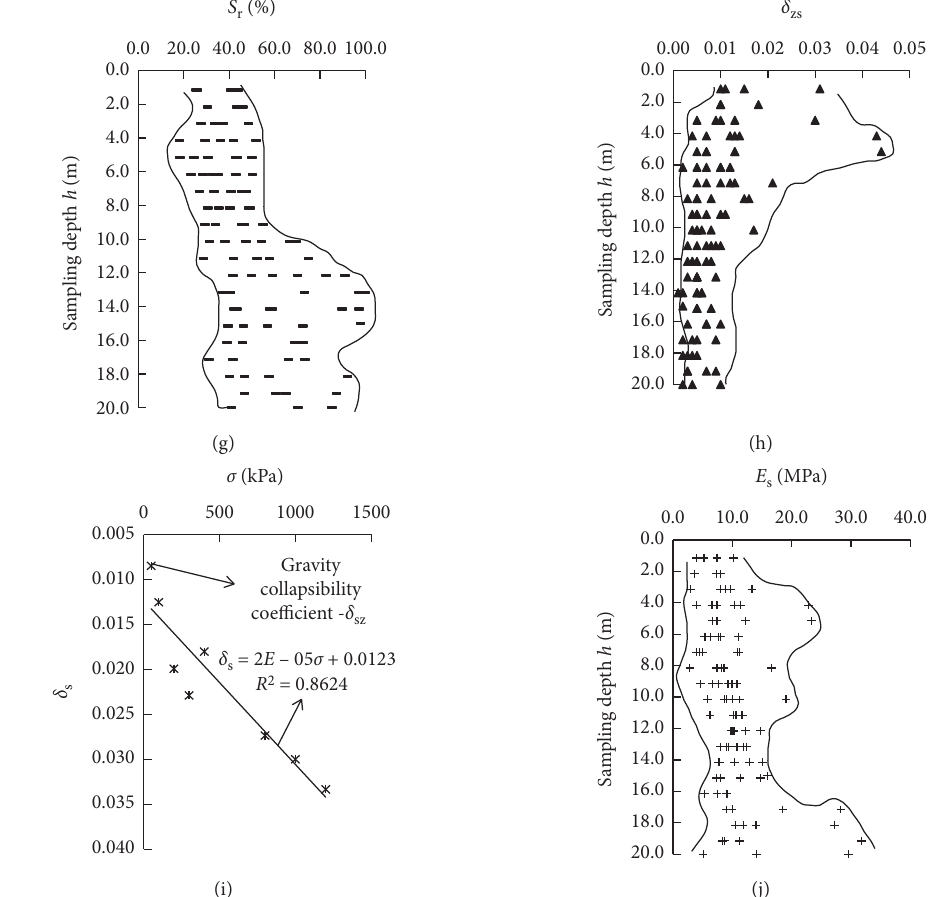
Figure 2: Profile of the stratum of the test section and physical-mechanical parameters of soil samples. (a) Profile of the stratum of the test section of the airport. (b) Water content. (c) Dry density. (d) Void ratio. (e) Liquid limit. (f) Plastic limit. (g) Saturation degree. (h) Gravity